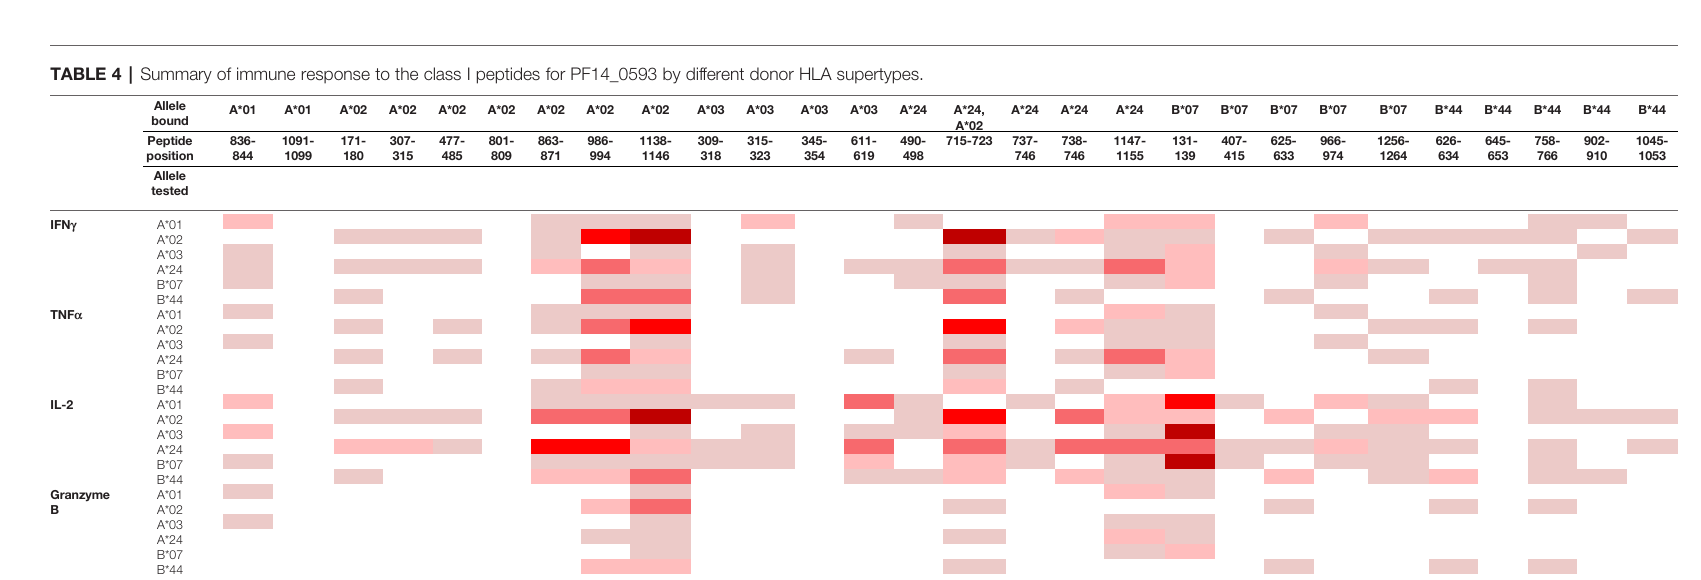
Individual peptidesare identi fi ed at the topofthe table. The speci fi ccytokineor protease measured is indicatedon the left side ofthe table. The color intensityindicates the number ofdonors in each HLA type which respondedto the peptide andfollows: 1 2 3 4 5-6 .